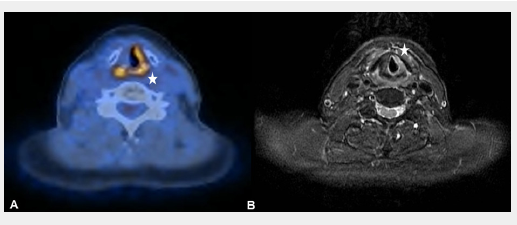
Table 4: Detailed information on all FDG-positive lesions considered to be due to inflammatory processes.